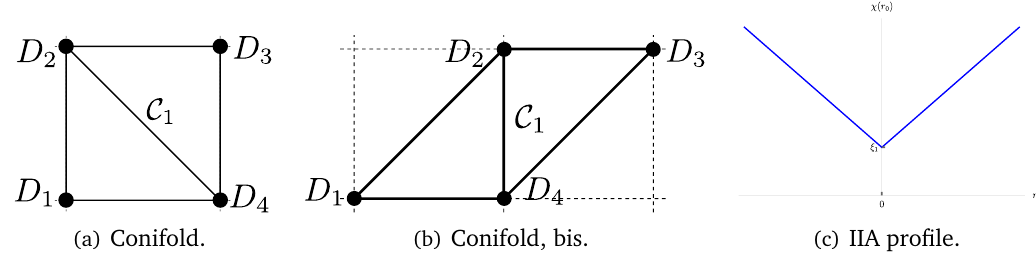
Figure 35: The two toric diagrams are related by an SL ( 2, (cid:90) ) transformation. The vertical reduction of the second toric diagram gives the IIA profile displayed on the